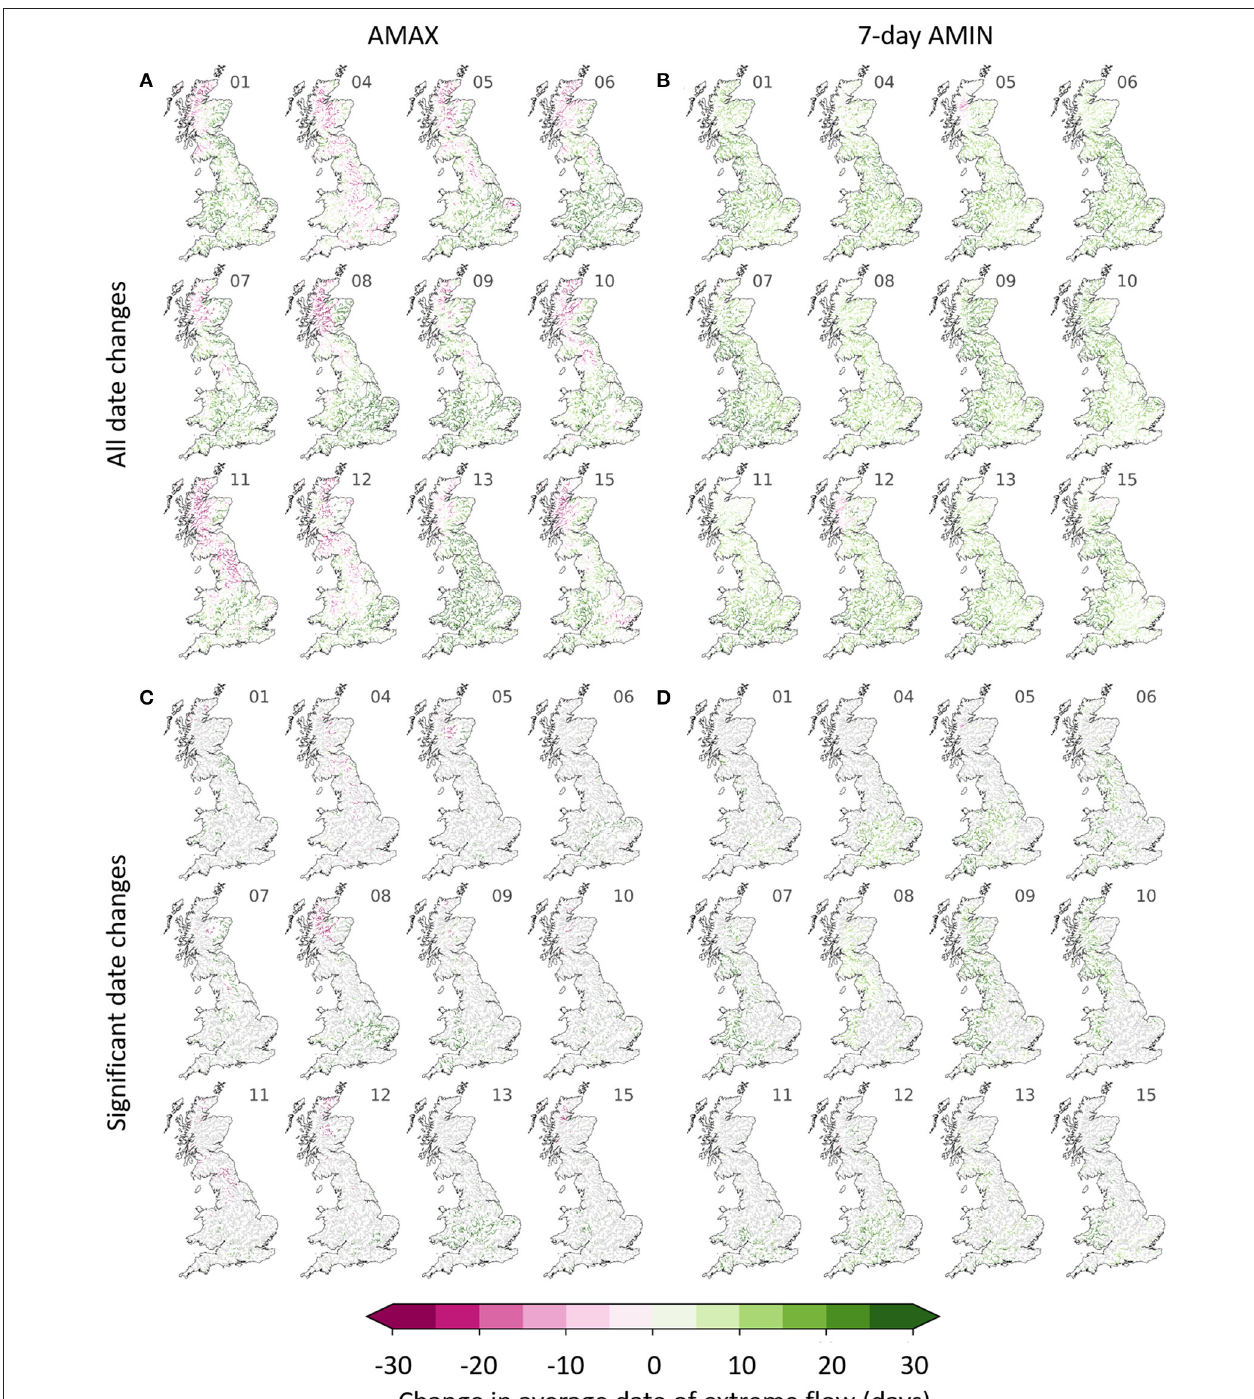
FIGURE 7 | Change in timing of extreme flows between baseline and future time periods for all non-tidal river pixels. All calculated changes are given on the top row for annual maximum (A) and 7-day annual minimum (B) flow dates. The plots on the bottom row show significant changes only for annual maximum (C) and minimum (D) flows, with all insignificant changes coloured grey. Results are given separately for all 12 UKCP18 ensemble members, with the ensemble member numbers given to the top-right of each map. These numbers are consistent with the Met Office UKCP18 RCM numbering.